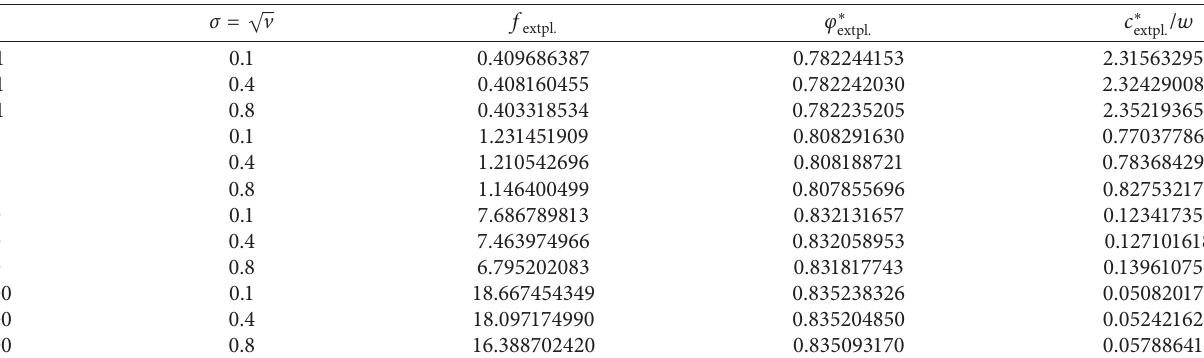
Table 13: Numerical solutions for f, φ ∗ , and c ∗ / w after performing Richardson’s extrapolation. Here, α � 0 . 9 and Δ τ � Δ v � 0 . 001. Other parameter values are the same as those in Table